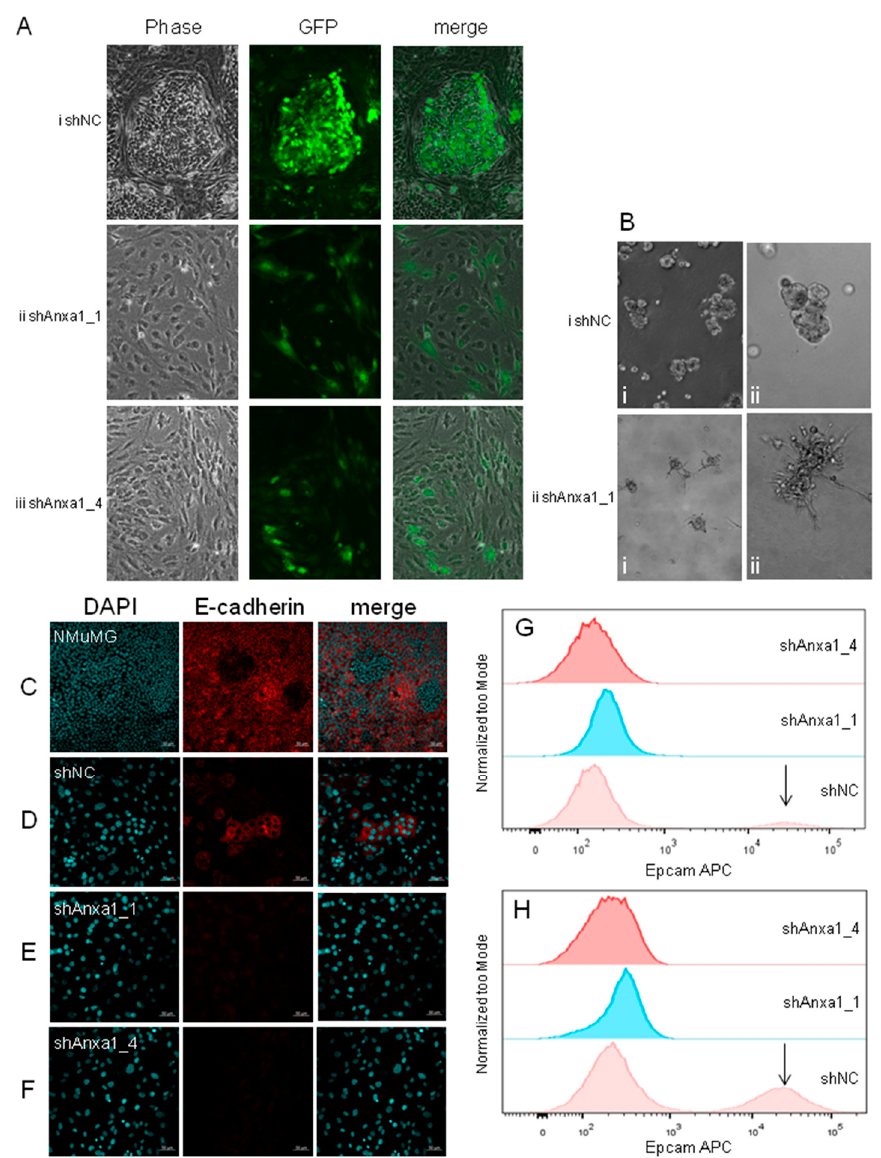
Figure 4 . Phenotypes of Annexin-A1-depleted PyMTneoLUC cells in vitro. ( A ) Phase contrast (left panels), fluorescent (eGFP, middle panels), and merged (right panels) images of the indicated PyMTneoLUC stable transfectants cultured for 4 days post confluence. ×100 magnification. ( B ) Mor- phology of control PyMTneoLUC_shNC and PyMTneoLUCshAnxa1_1 cells in 3D culture. ( i ) ×100 magnification. ( ii ) ×200 magnification. ( C ) NMuMG, ( D ) PyMTneoLUC_shNC, ( E ) PyMTneo- LUC_shAnxa1_1, and ( F ) PyMTneoLUC_shAnxa1_4 cells were grown 4 days post confluence and stained for nuclei (DAPI, left panels), E-cadherin (red, middle panels), and the images merged (right panels). Scale bars are 50 μ m. ( G , H ) The indicated PyMTneoLUC stable transfectants were cultured in vitro and cells collected at confluence ( G ), or 4 days post-confluence ( H ), for analysis of cell sur- face Epcam expression by flow cytometry. The Epcam HI population in PyMTneoLUC_shNC cells is indicated with an arrow.